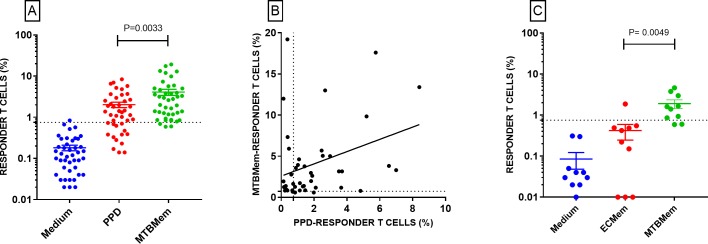
Relative potency and specificity of the T cell response induced by MTBMem.Dashed lines denote cutoff for a positive cell-proliferative response (= 0.75% responder cells). [A] MTBMem produced significantly higher (P <0.01) response than PPD. [B] A weak (r = 0.33) though significant (P <0.05) correlation was seen between responses to MTBMem and PPD. [C] MTBMem also produced a significantly higher (P <0.01) response than E. coli membrane (ECMem).